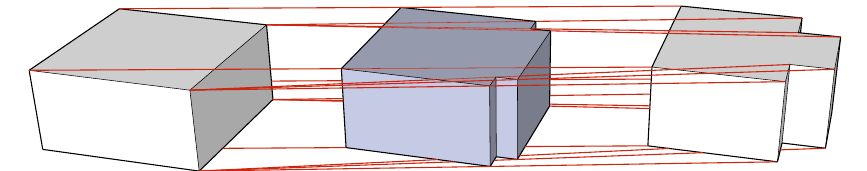
Figure 3. Two LODs of a house with differing geometry and topology are integrated into a 4D model by collapsing cells in the model at the highest